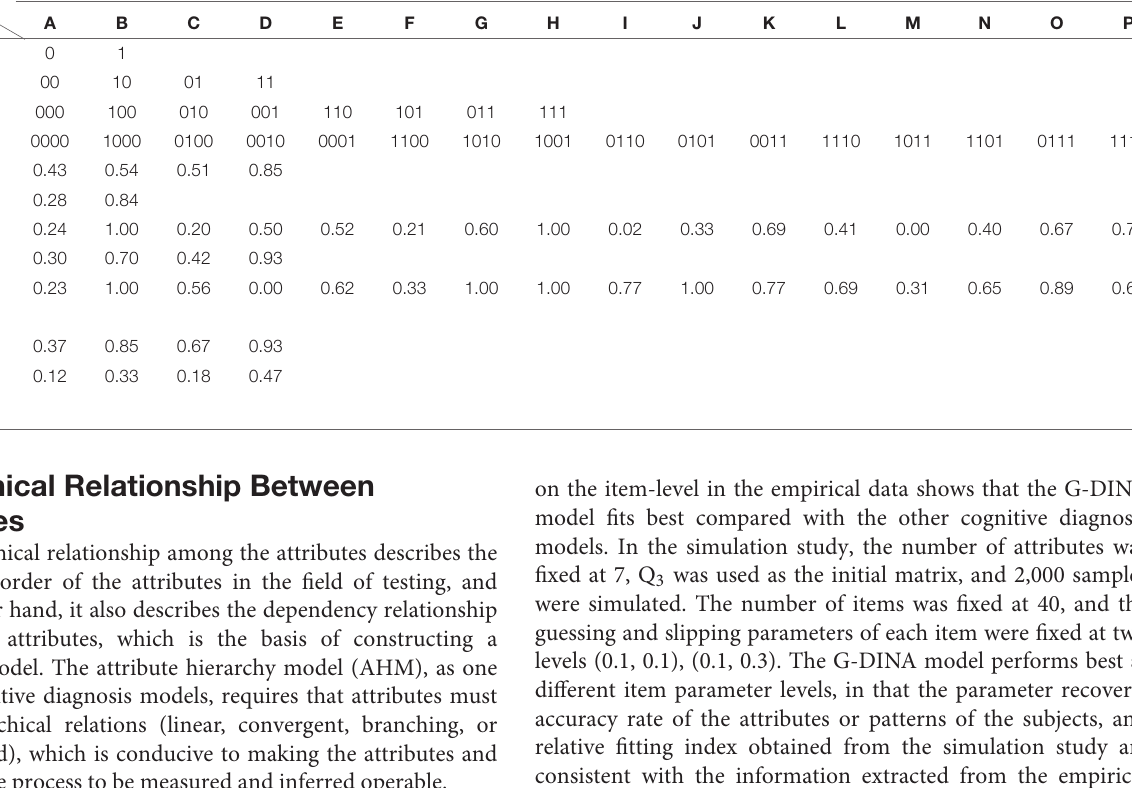
TABLE 9 | Estimation of the probability of answering the question correctly. Pattern Item